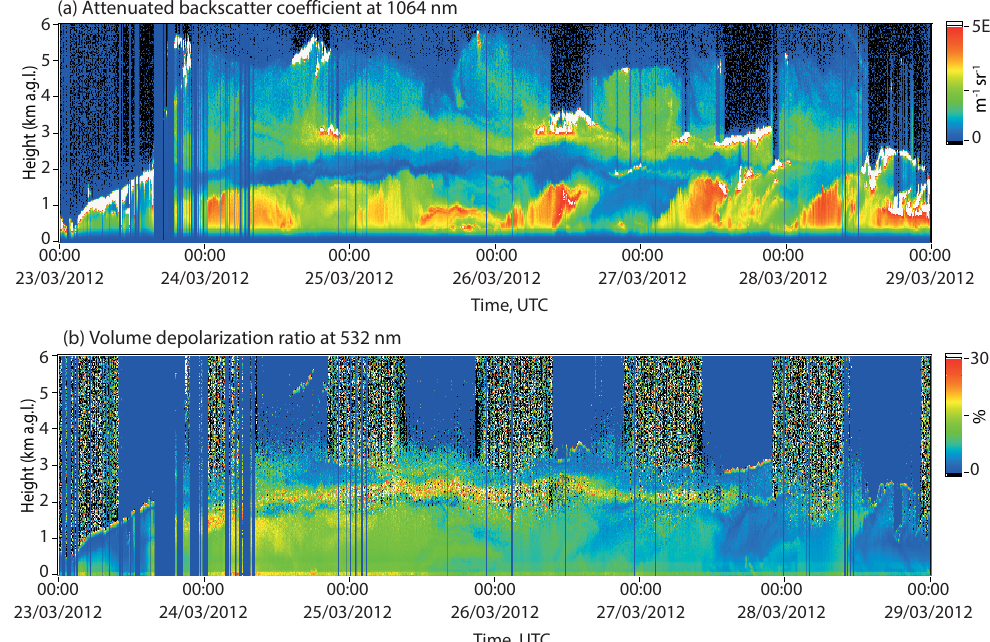
Figure 2. Attenuated backscatter coefficient at 1064nm (a) and volume depolarization ratio at 532nm (b) for the 5-day period from 23 to 28 March 2012. The blue, vertical lines in the plots occur when the laser is automatically switched off due to rain events. This may also be caused by insects flying through the rain sensor.